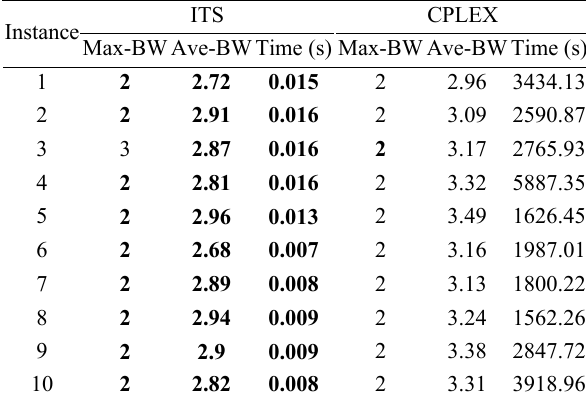
Table 2 Results of ITS and CPLEX for 10 instances ( m =